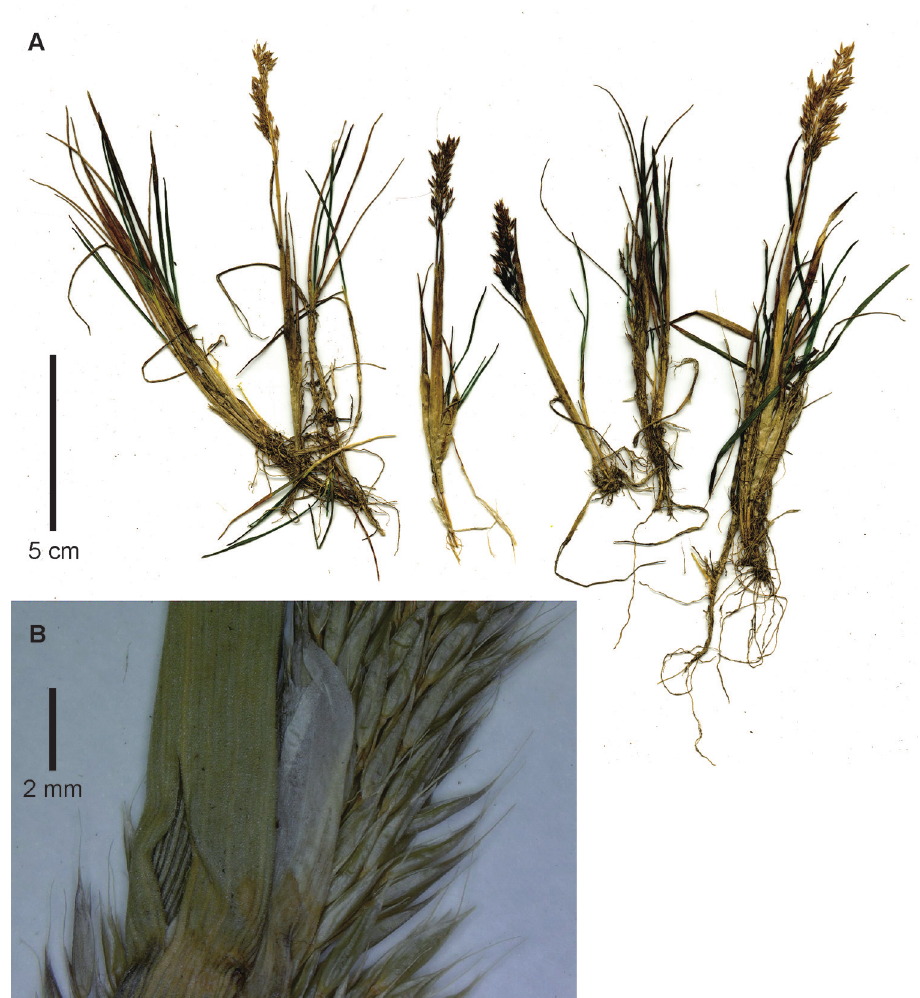
Figure 5. Agrostis foliata A whole plant B flag ligule and portion of inflorescence. Image A Sylvester 3151 (FMB) B Grubb 306 (US2304908).